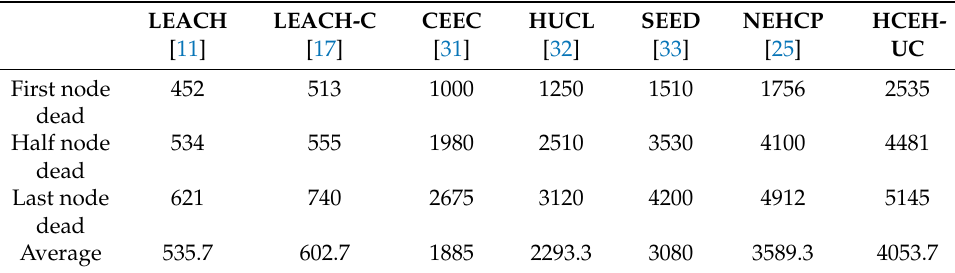
Figure 3. Data transmission rounds before the first node dead (FND). Table 4. Lifetime metrics of the sensor